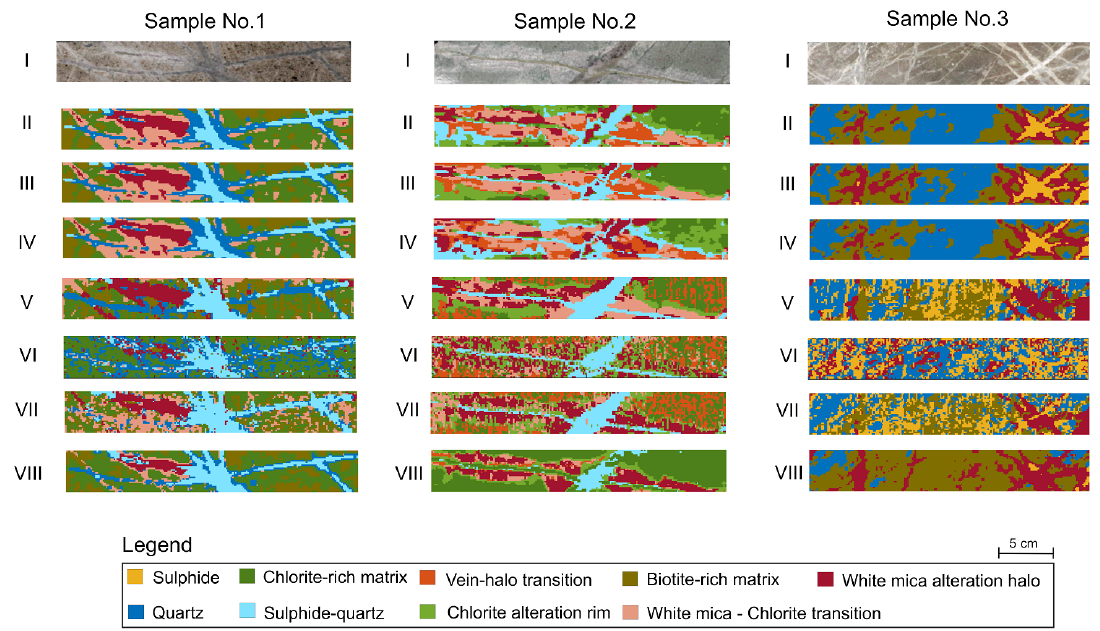
Figure 7. Clustering results of the three investigated samples based on the automatically generated number of clusters. Sample No. 1, Sample No. 2, and Sample No. 3 include 6, 6, and 4 clusters, respectively. (I) RGB image of the drill-cores, and the clustering results obtained by (II) K-means, (III)